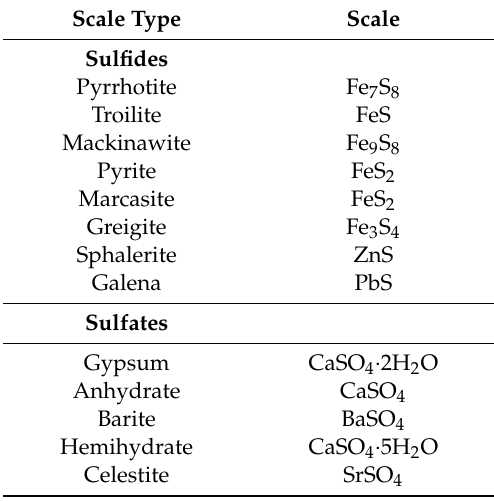
Table 1. Di ff erent Types of